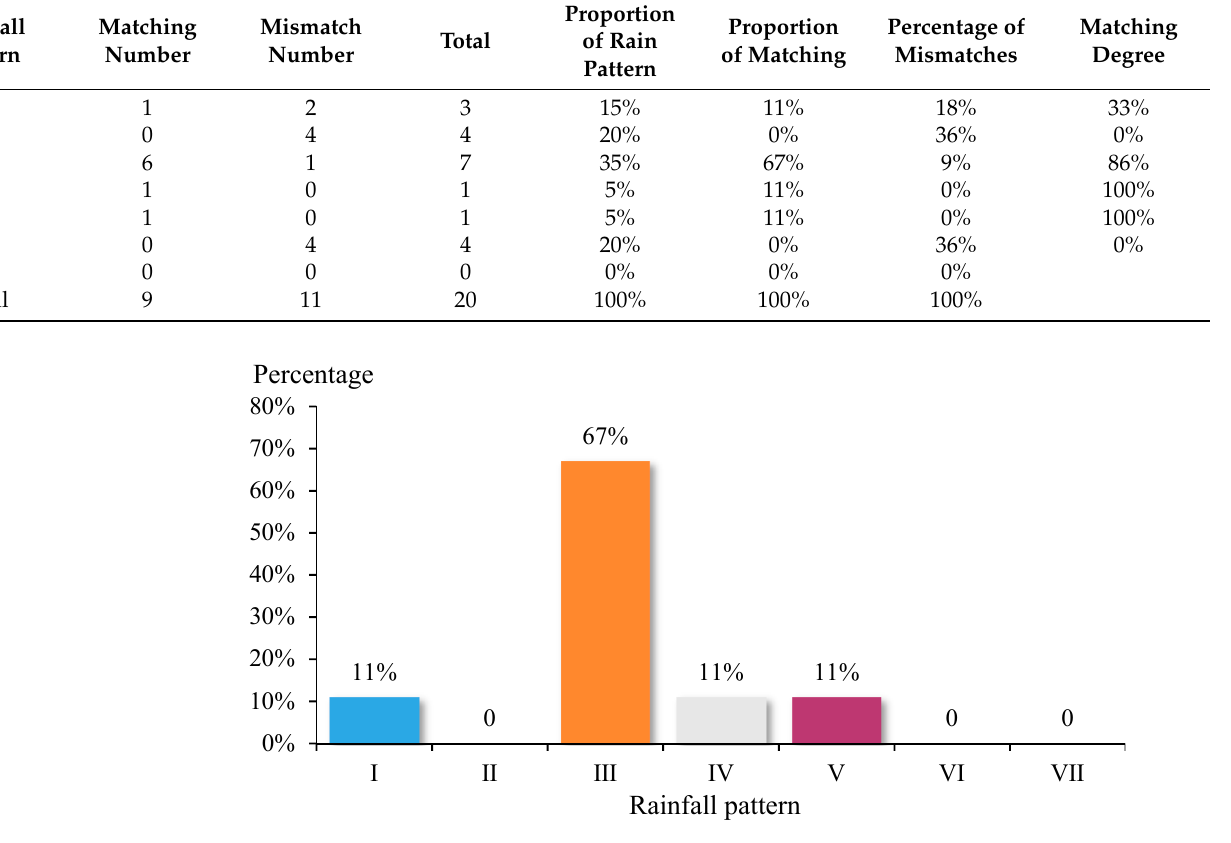
Figure 13. Matching results of the rain patterns identified by the unstructured data and the meas- ured data.